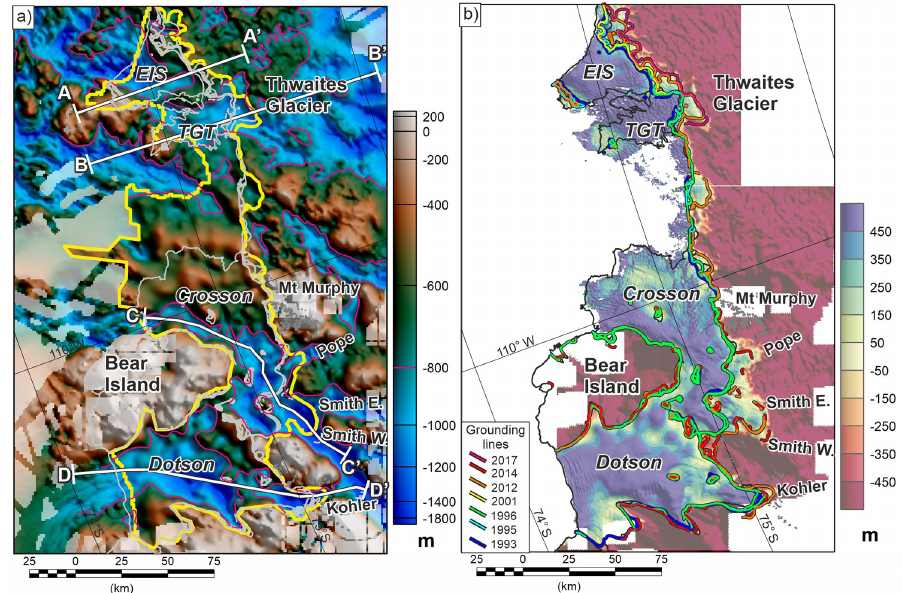
Figure 2. New bathymetry and cavity maps. (a) Final topography from terrain shift method. White lines A–D mark profiles in Fig. 3. The yellow outline encloses the region constrained by gravity data. The pink line shows the − 800m depth contour. Light grey lines mark grounding lines and the ice shelf edge. (b) Sub-ice-shelf water column thickness based on the new gravity-derived bathymetry and the REMA DEM with an assumption of hydrostatic equilibrium. Regions where the ice sheet is predicted to be grounded show negative cavity